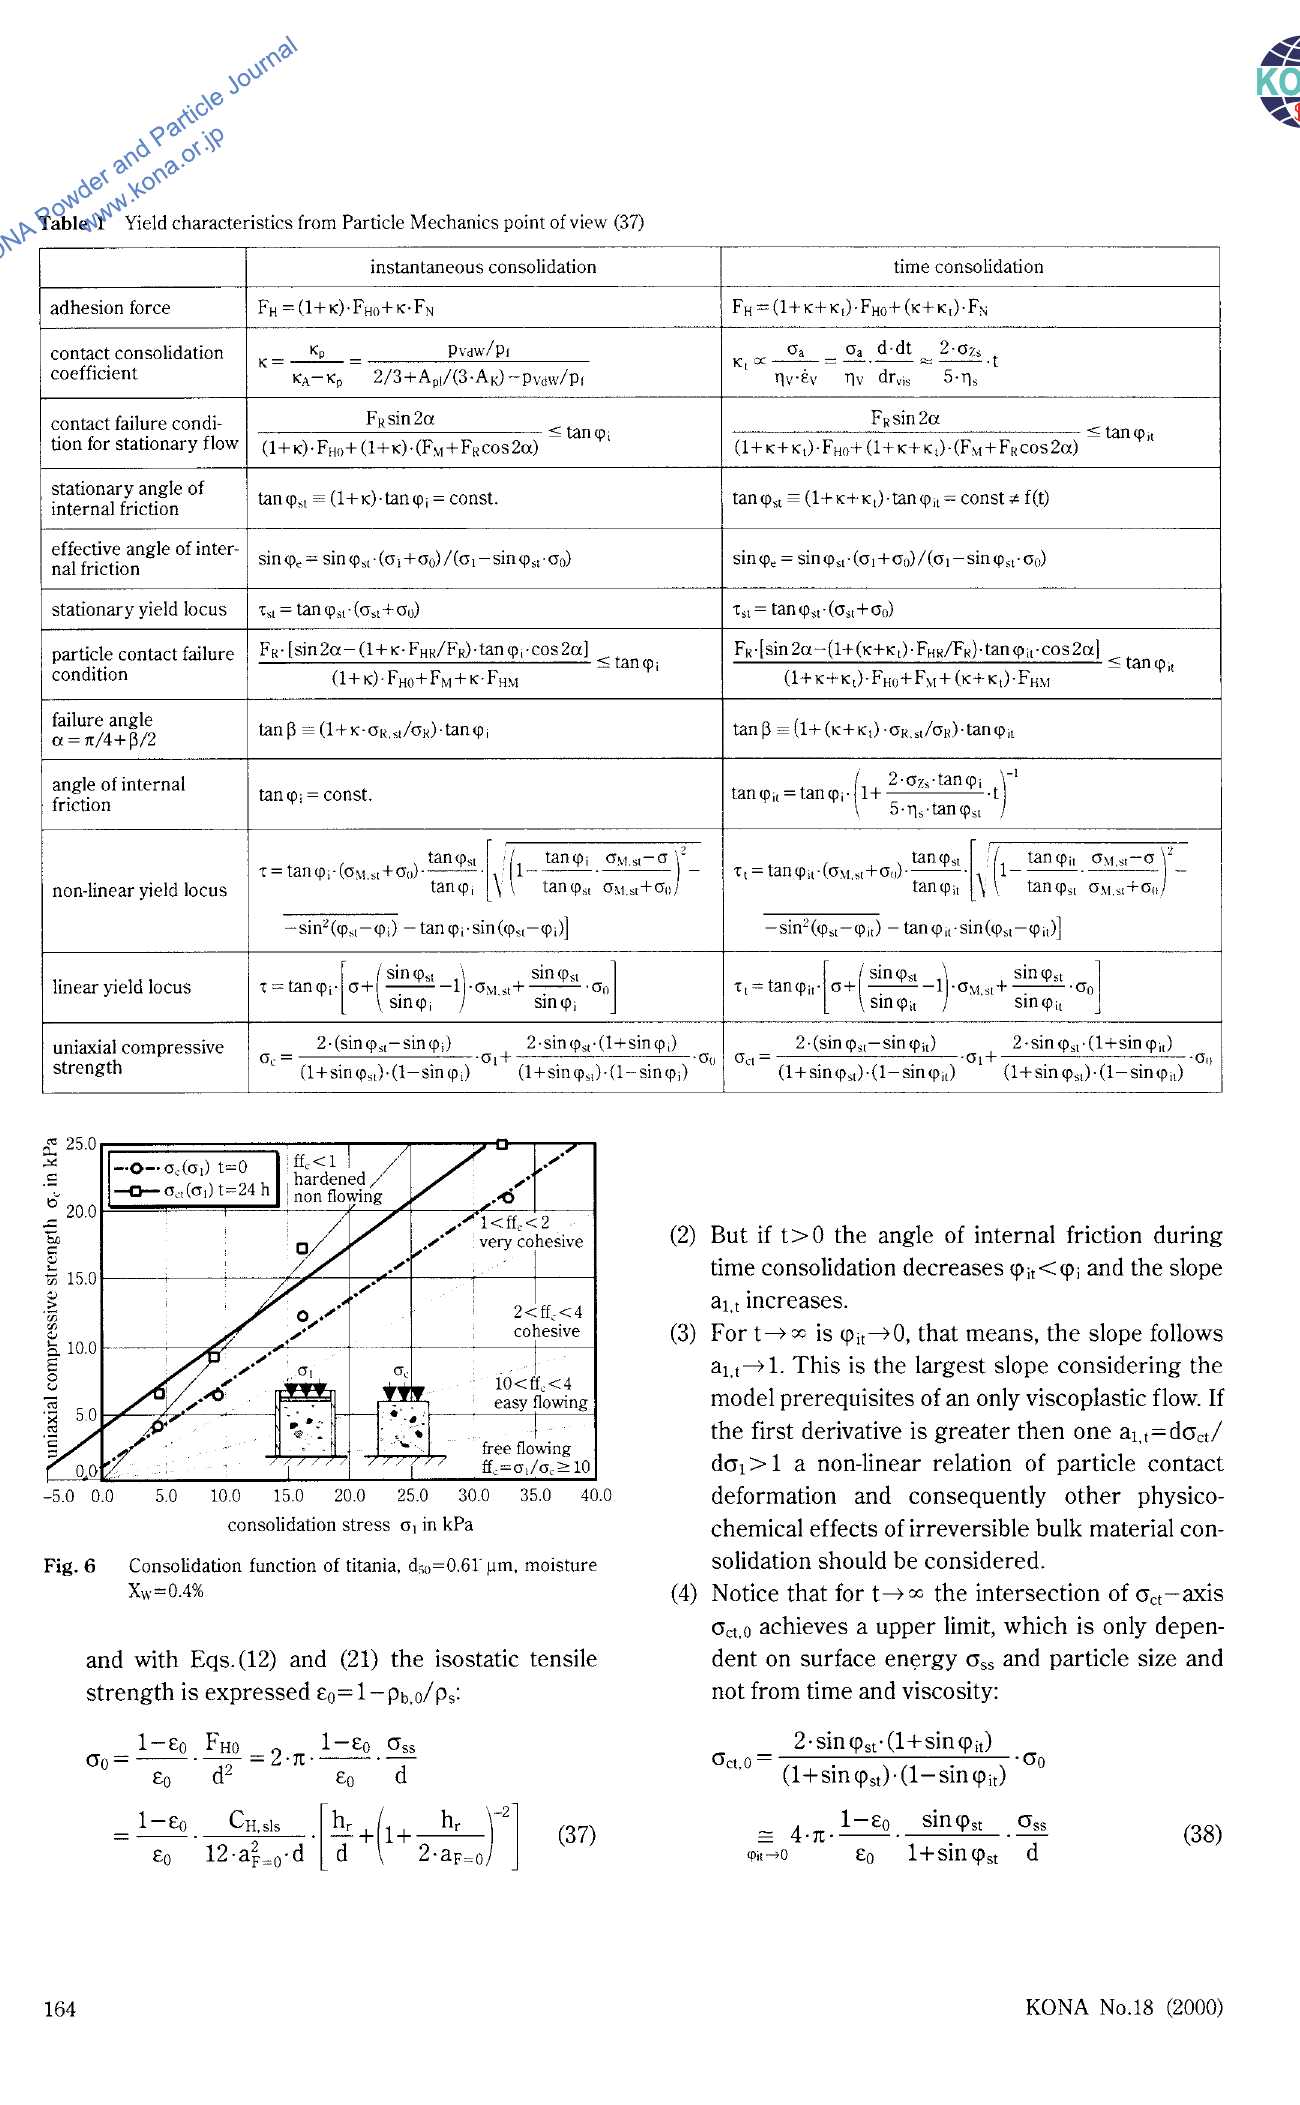
Consolidation function of titania. ds 0 =0.6l!lm. moisture